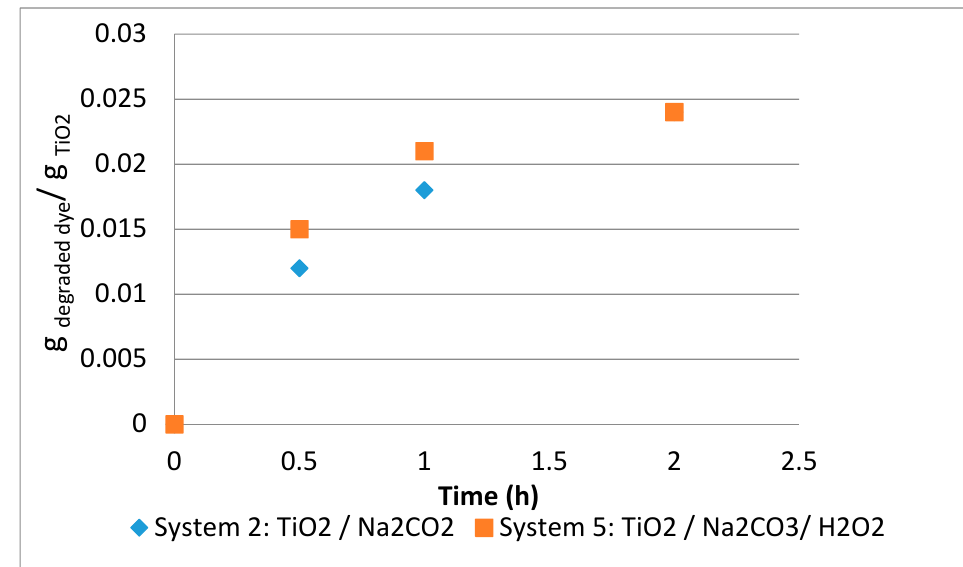
Figure 18. Comparison between the dye degradation curves for Systems 2 and 5.